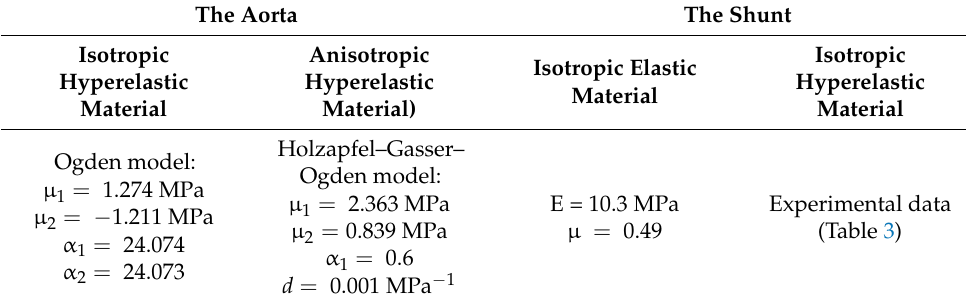
Table 5. Mechanical parameters for aorta and shunt used in the study.